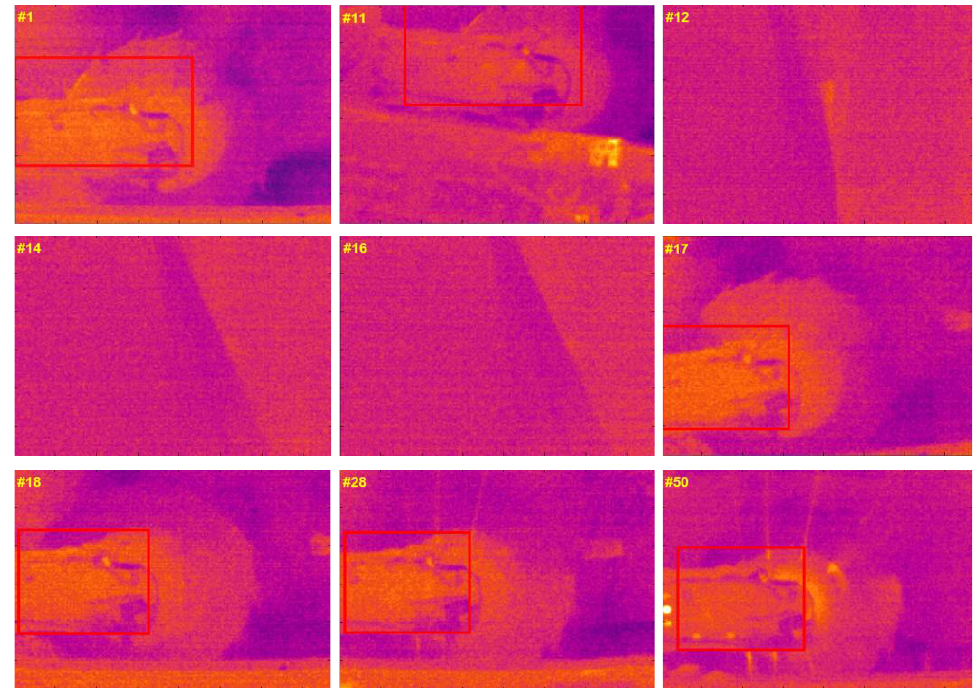
Figure 16. Tracking results of the cutting unit based on the morphology and the STC algorithm.